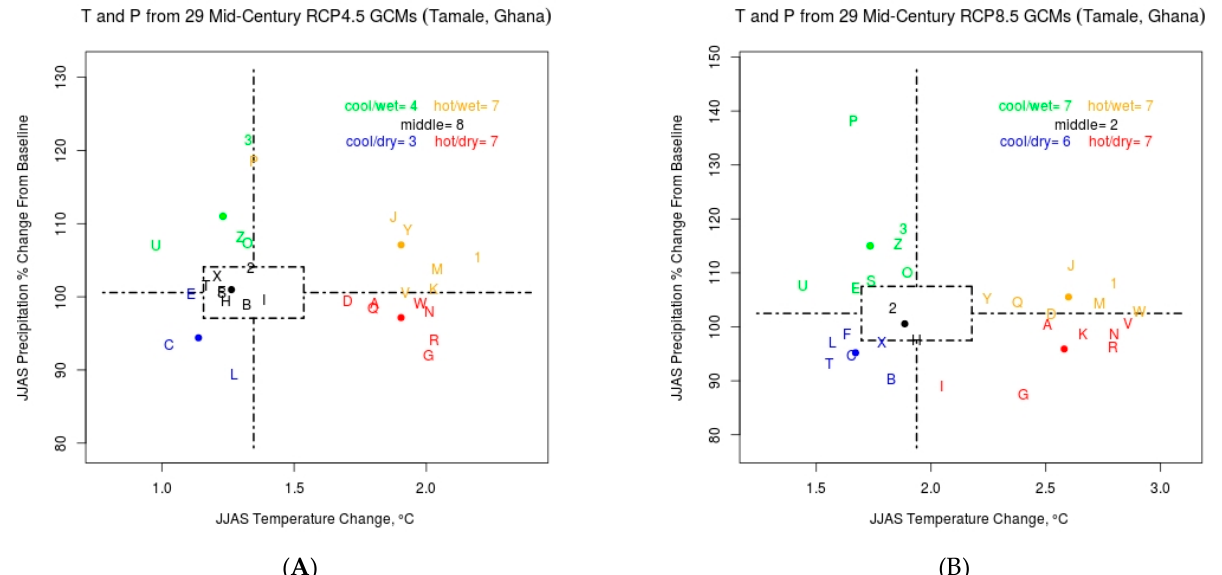
Figure 4. Scatterplots of changes in precipitation and temperature over the growing season (JJAS—June, July, August, and September) for Tamale, Ghana, for 29 general circulation models (GCM) under 2 representative concentration pathways (RCP), namely, ( A ) RCP 4.5 and ( B ) RCP 8.5. The letters denote each of the 29 GCMs that best capture West African weather variability. The 5 dots in each of the 5 clusters of GCM represent the median for the respective cluster. The 5 GCMs selected under RCP 4.5 are: W, CMCC-CMS; Z, IPSL-CM5A-LR; F, CESMI-BGC; Y, HadGEM2-AO; and C, BNU-ESM; and for RCP 8.5: O, MIROC5; Z, IPSL-CM5B-LR; I, GFDL-ESM2; D, CanESM2; and K,